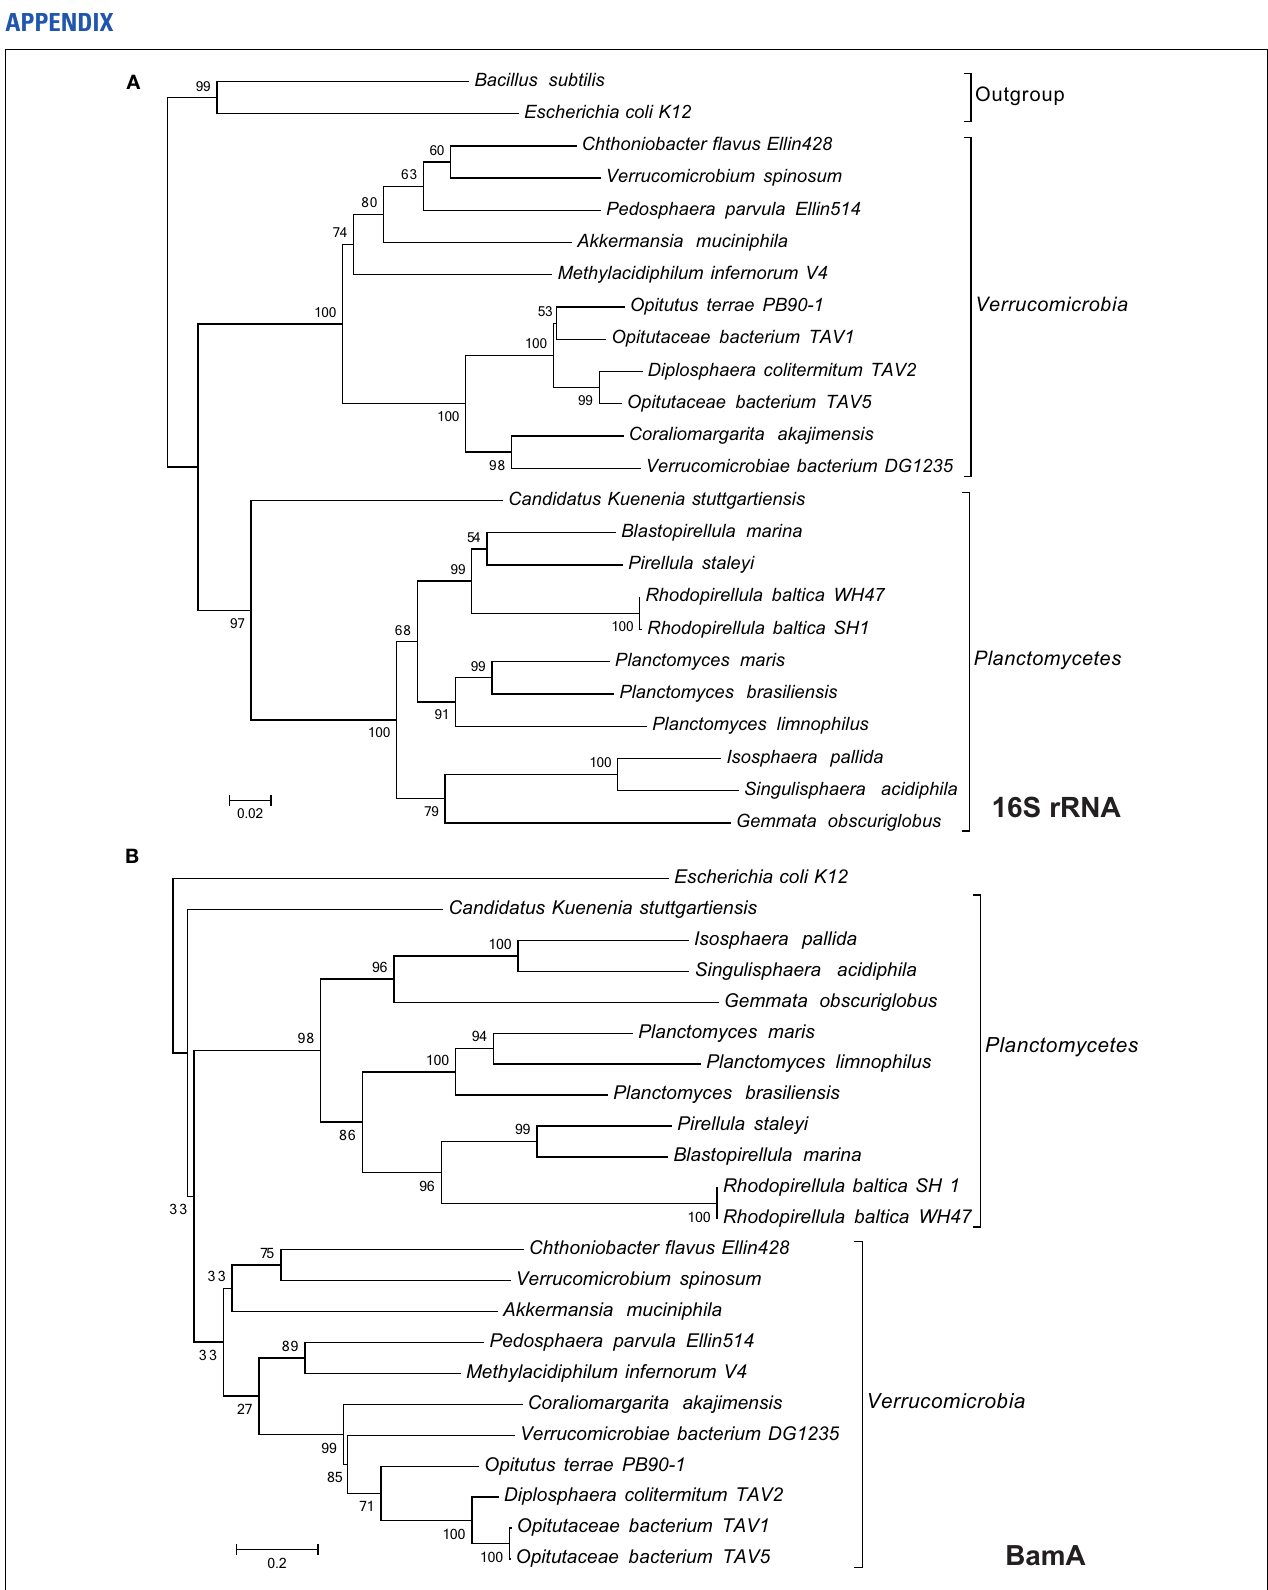
FIGUREA1 | Maximum likelihood trees of Planctomycetes andVerrucomicrobia based on 16S rRNA nucleotide (A) and BamA protein (B) sequences .